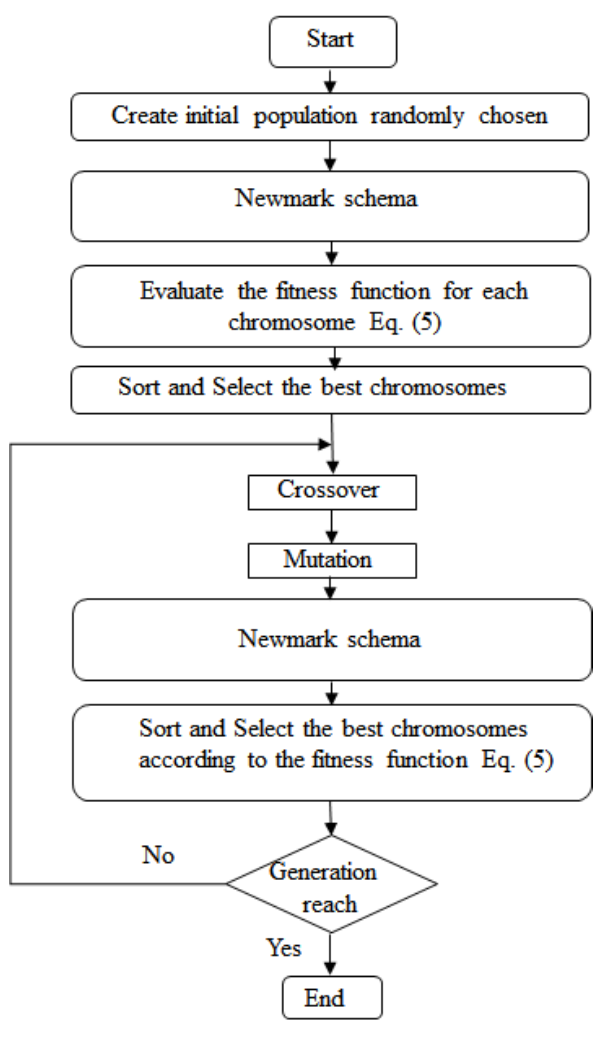
Fig. 1 Flowchart of the genetic algorithm used in the placement